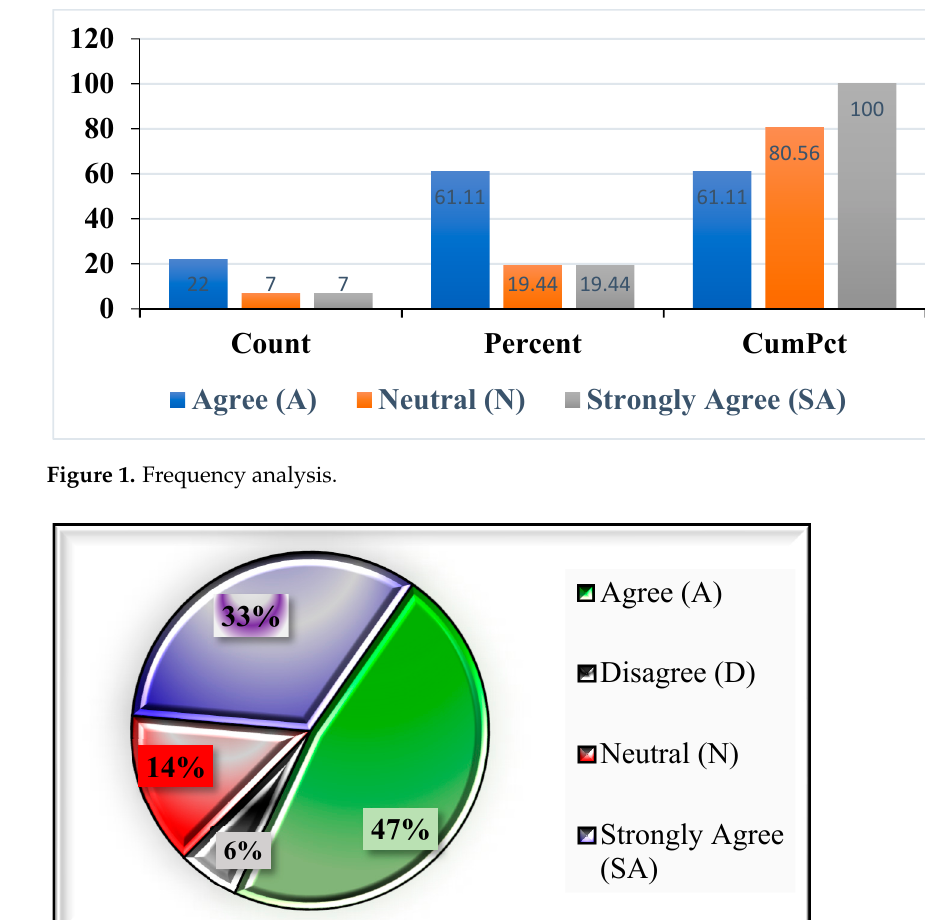
Figure 2. Progress tracking with agile methodology.